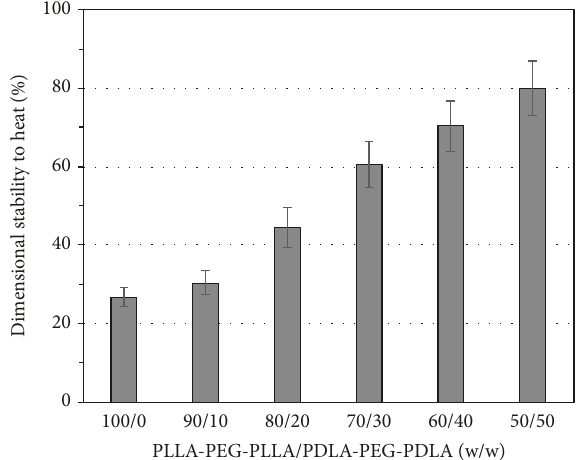
Figure 7: Dimensional stability to heat of PLLA-PEG-PLLA/PDLA- PEG-PDLA blend